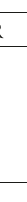
Table 4: Reconstructed image quality using proposed asymmetric turbo code over AWGN channel.